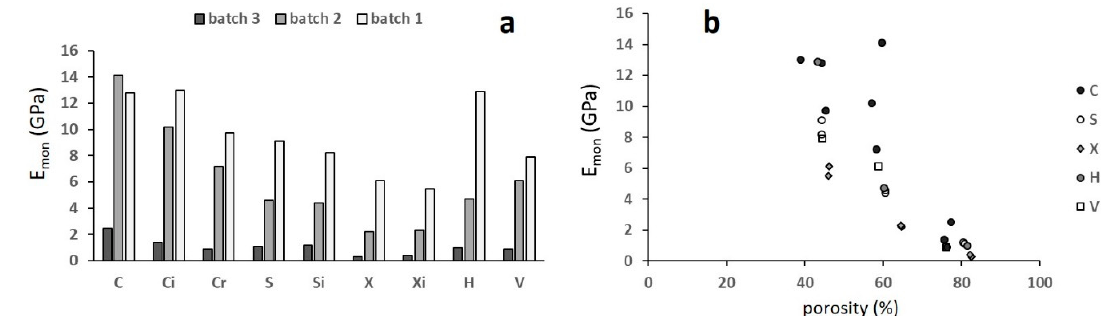
Figure 8. ( a ) The quasi elastic gradient and ( b ) its correlation with porosity; the letters refer to different structures. Scatter ±1 GPa.